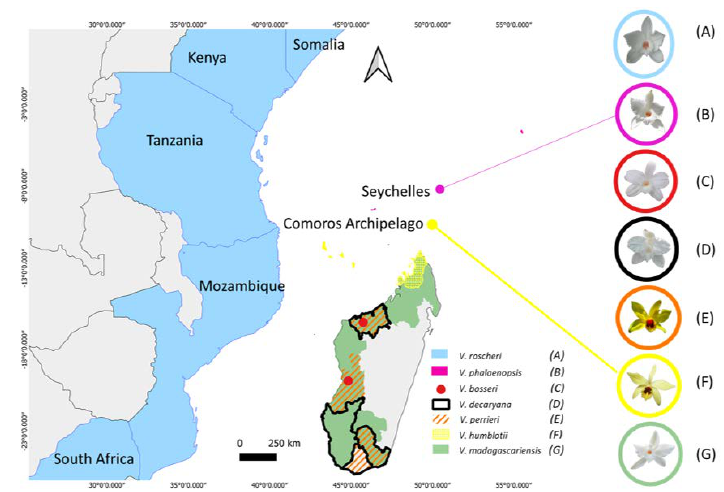
Figure 5. Distribution area of the seven leafless Vanilla species from the SWIO region according to Allorge-Boiteau [34], Allorge-Boiteau [35], Cribb and Hermans [8], Chinsamy, Finnie, and Van Staden [5], Luke [94], Port è res [10]. Species are numbered from A to G. Images of their flowers are shown: photographies by ( A ) Rodolphe Gigant near Sibaya Lake (South Africa), ( B ) Thierry Pailler in Seychelles, ( C ) Cathucia F. Andriamihaja in Marosely (Madagascar), ( D ) Hoby Nomenjanahary in Mangily (Madagascar). ( E ) Cathucia F. Andriamihaja in Befandrama (Madagascar), ( F ) Johnson G. Andrianantenaina in Montagne des Français Park (Madagascar), and ( G ) Alemao Botomanga in Maromandia